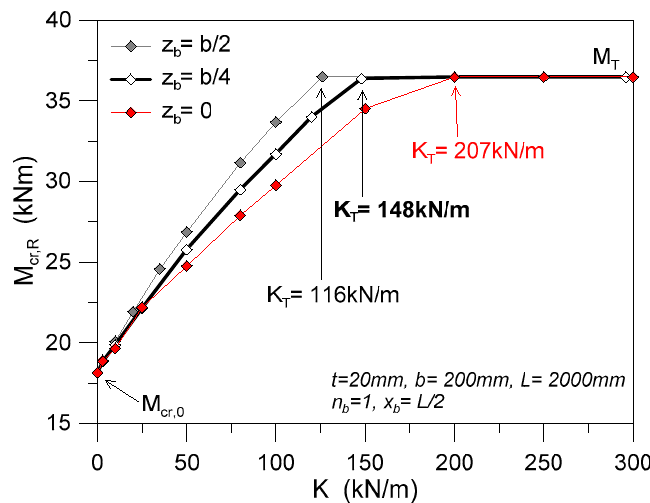
Figure 13. Comparative LTB calculations for selected LR glass beams with n b = 1 discrete lateral restraints at different positions z b ( K = var), using ABAQUS.